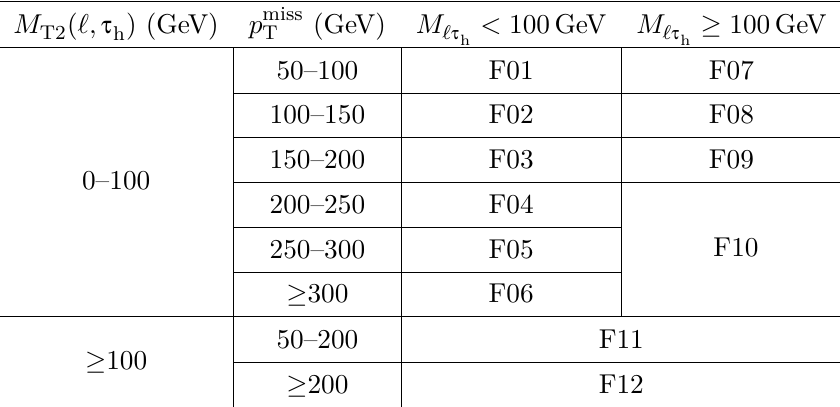
candidates and one light lepton